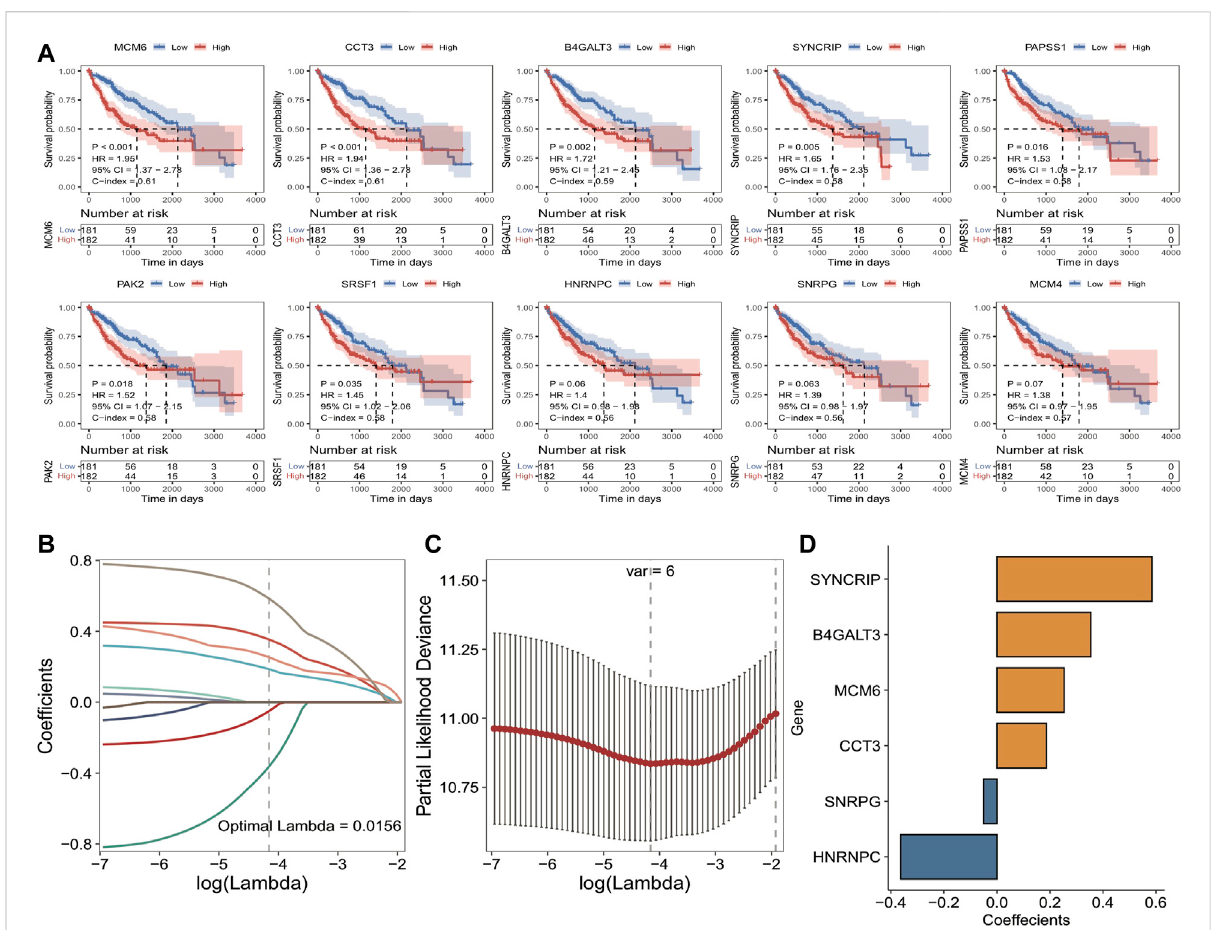
FIGURE 4 Results of TCGA training set cox analysis and Lasso regression analysis. (A) KM curves of prognostic signatures obtained from COX analysis; (B) Trajectories of the independent variables of LASSO regression, the horizontal coordinates indicate the logarithm of the independent variable Lambda, and the vertical coordinates indicate the coef fi cients of the independent variables; (C) LASSO regression under each Lambda con fi dence interval; (D) LASSO regression coef fi cients of key prognostic